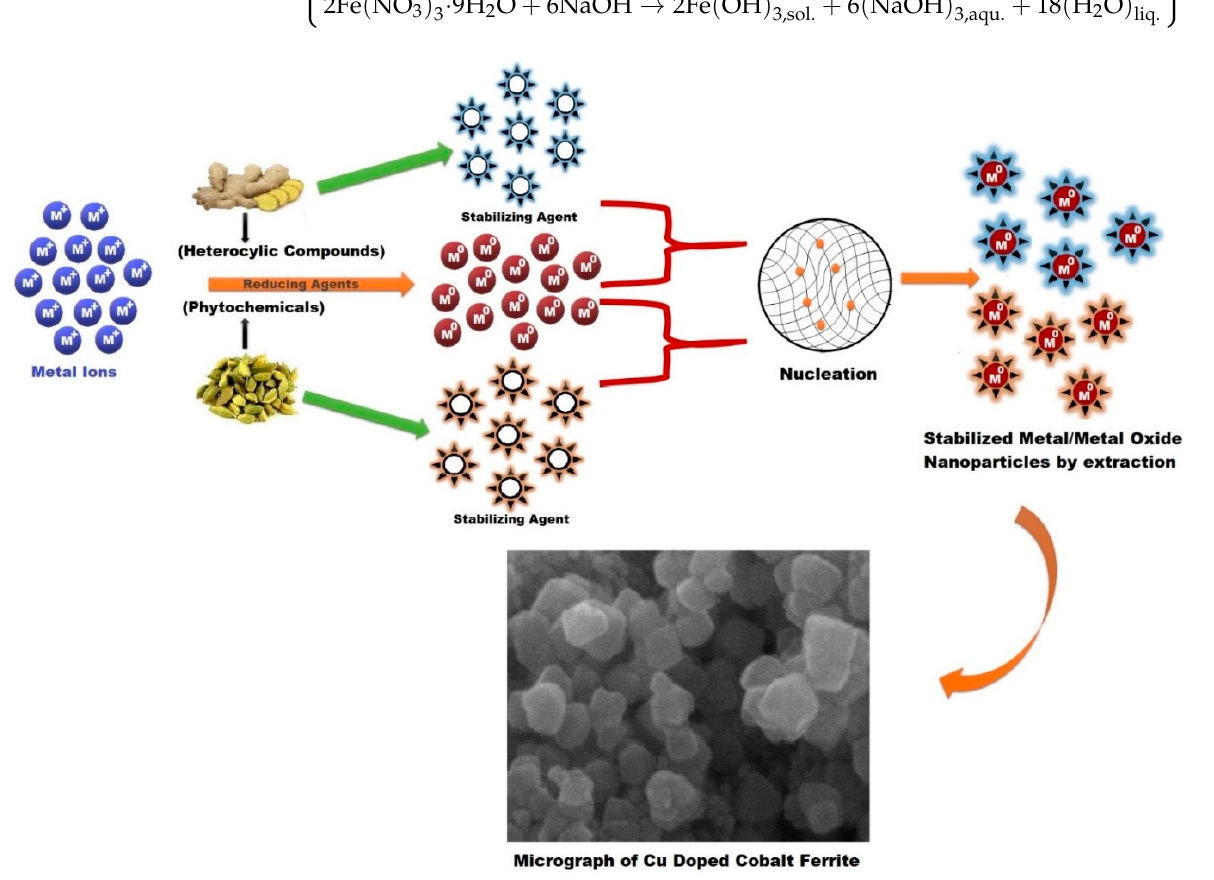
Figure 12. Schematic representation of growth mechanism of Cu x Co 1 − x Fe 2 O 4 : metal ions from precursors undergo reduction process in presence of phytochemicals/heterocyclic compounds. The process is initiated through nucleation of metallic substances; thereafter, nanoparticle growth